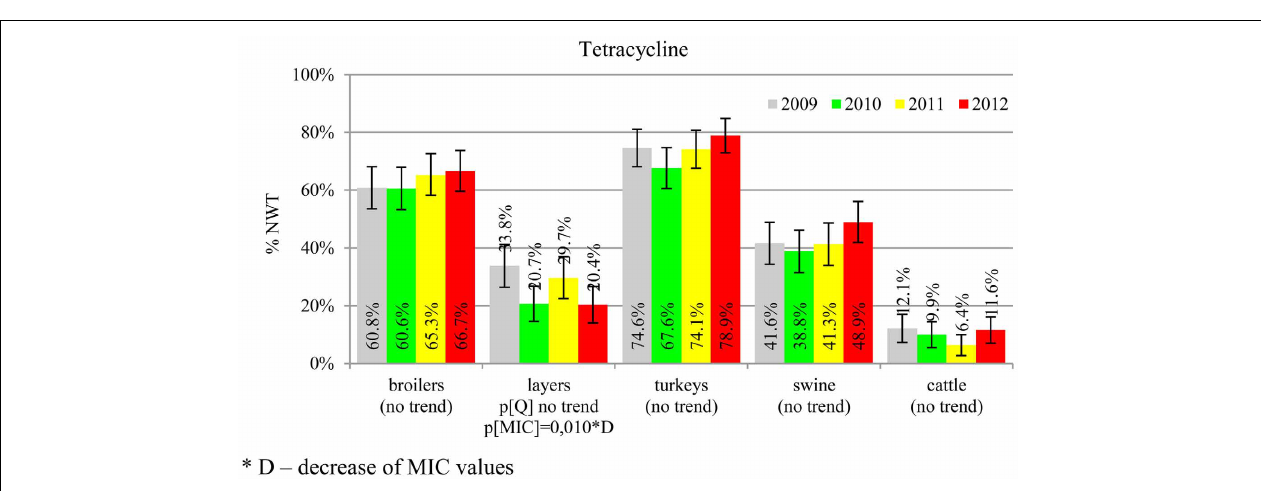
FIGURE 6 | Microbiological resistance to